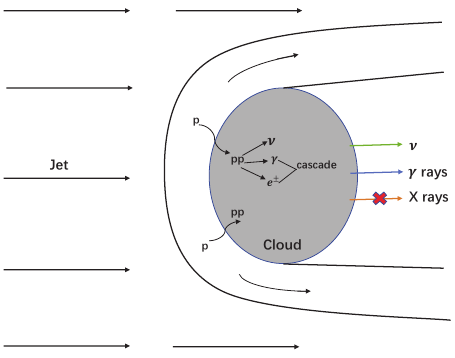
Figure 1. The sketch (not to scale) of jet-cloud interaction after the intrusion of a cloud into the jet flow. See Section 2 for more